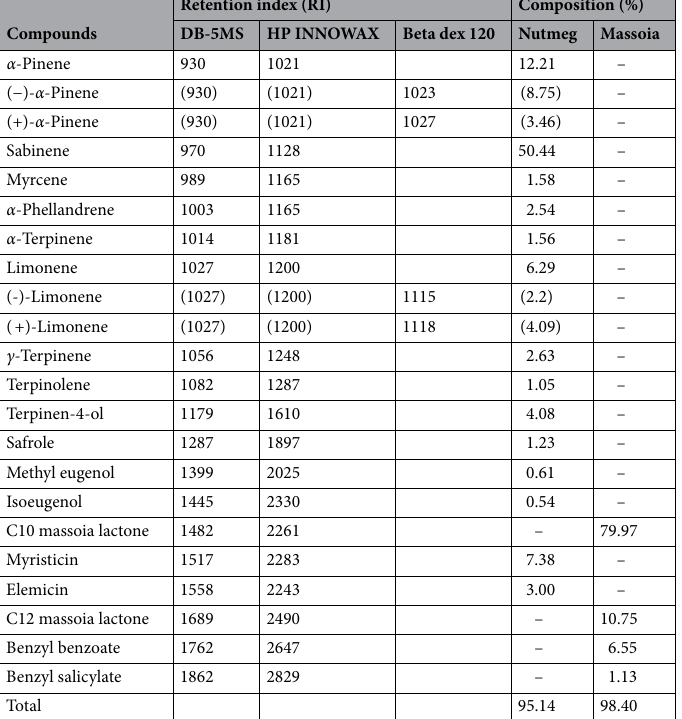
Table 2. Chemical analysis of massoia and nutmeg